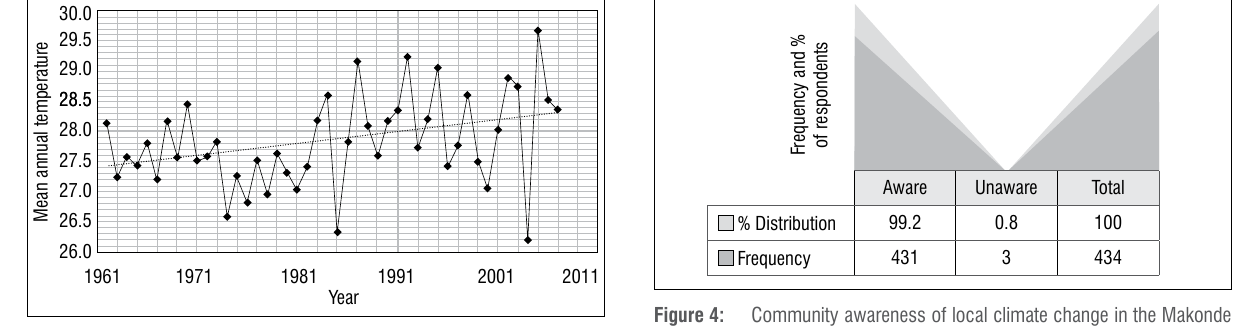
Figure 2: Mean annual temperature (°C) changes in the Makonde Rural District from 1962 to 2008.